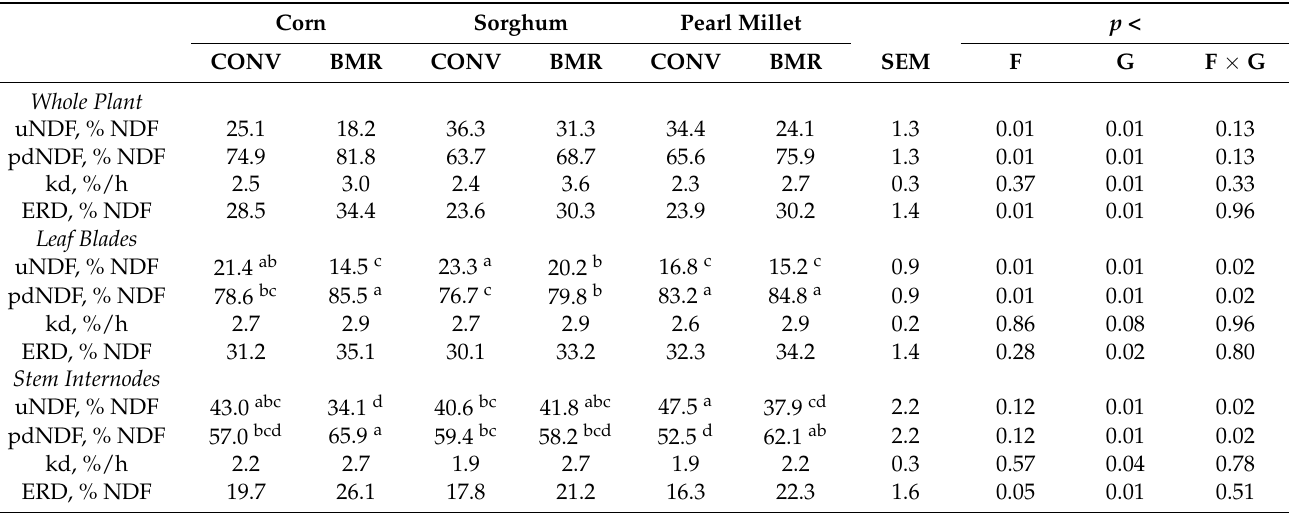
Table 2. Fiber degradation kinetic parameters † for whole plants and plant tissues of warm-season annual grasses of different forage types (F) and genotypes ‡ (G). Corn Sorghum Pearl Millet